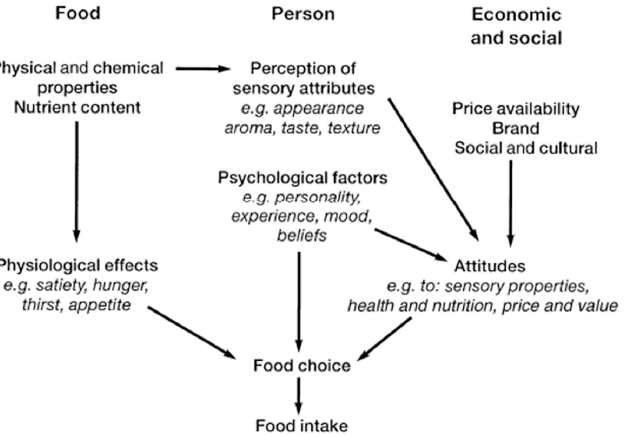
Figure 1. Shepherd (1985) model summarizing factors affecting food choice and intake adopted from Shepherd (1999) [19].